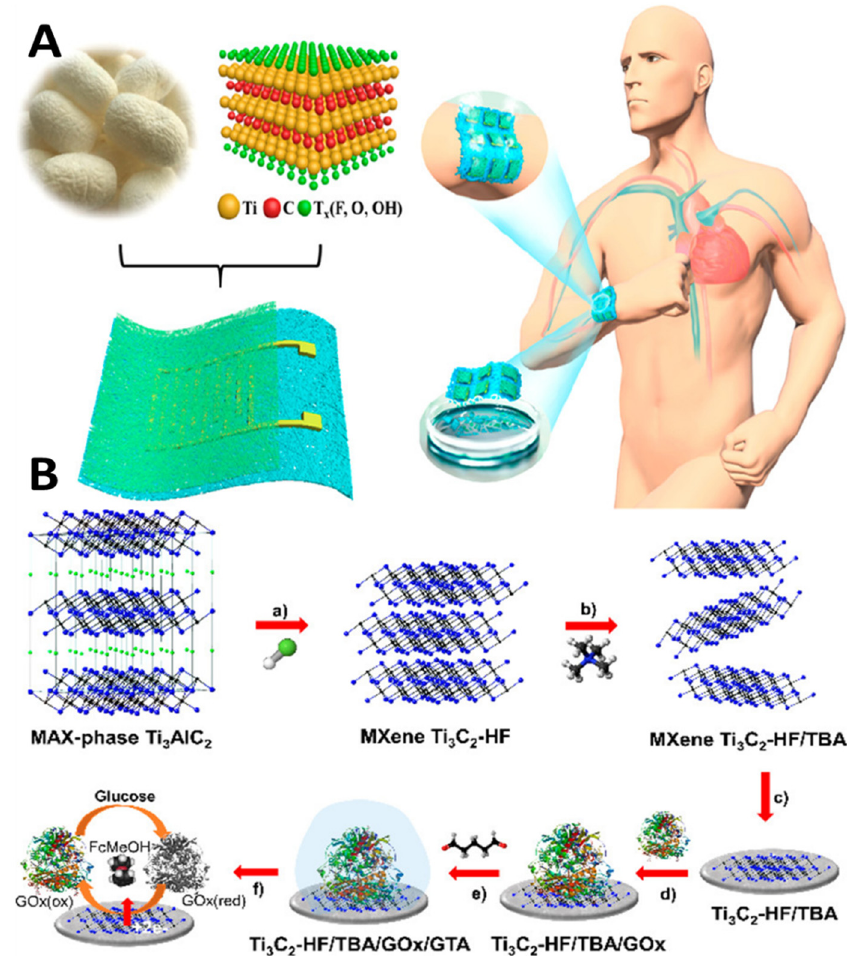
Figure 5. Mxene as a breathable and biodegradable material for developing E-skin-based pressure sensors ( A ). Utilizing the HET and high surface area of Mxene for developing second-generation glucose-monitoring devices ( B ). (Reproduced with permission from the American Chemical Soci- ety).